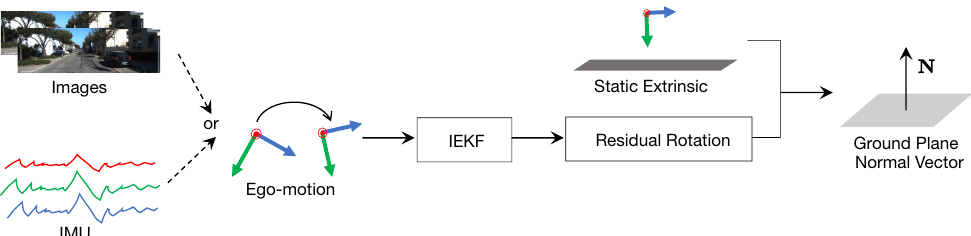
Figure 5. Overview of our proposed ground plane normal estimation pipeline. Our proposed IEKF can process ego-motion from various sensors, such as IMU, visual odometry from monocular images, and SLAM systems that can provide real-time odometry information. The final ground plane normal vector N is predicted in real-time based on the combination of residual rotation from IEKF and static extrinsic from prior